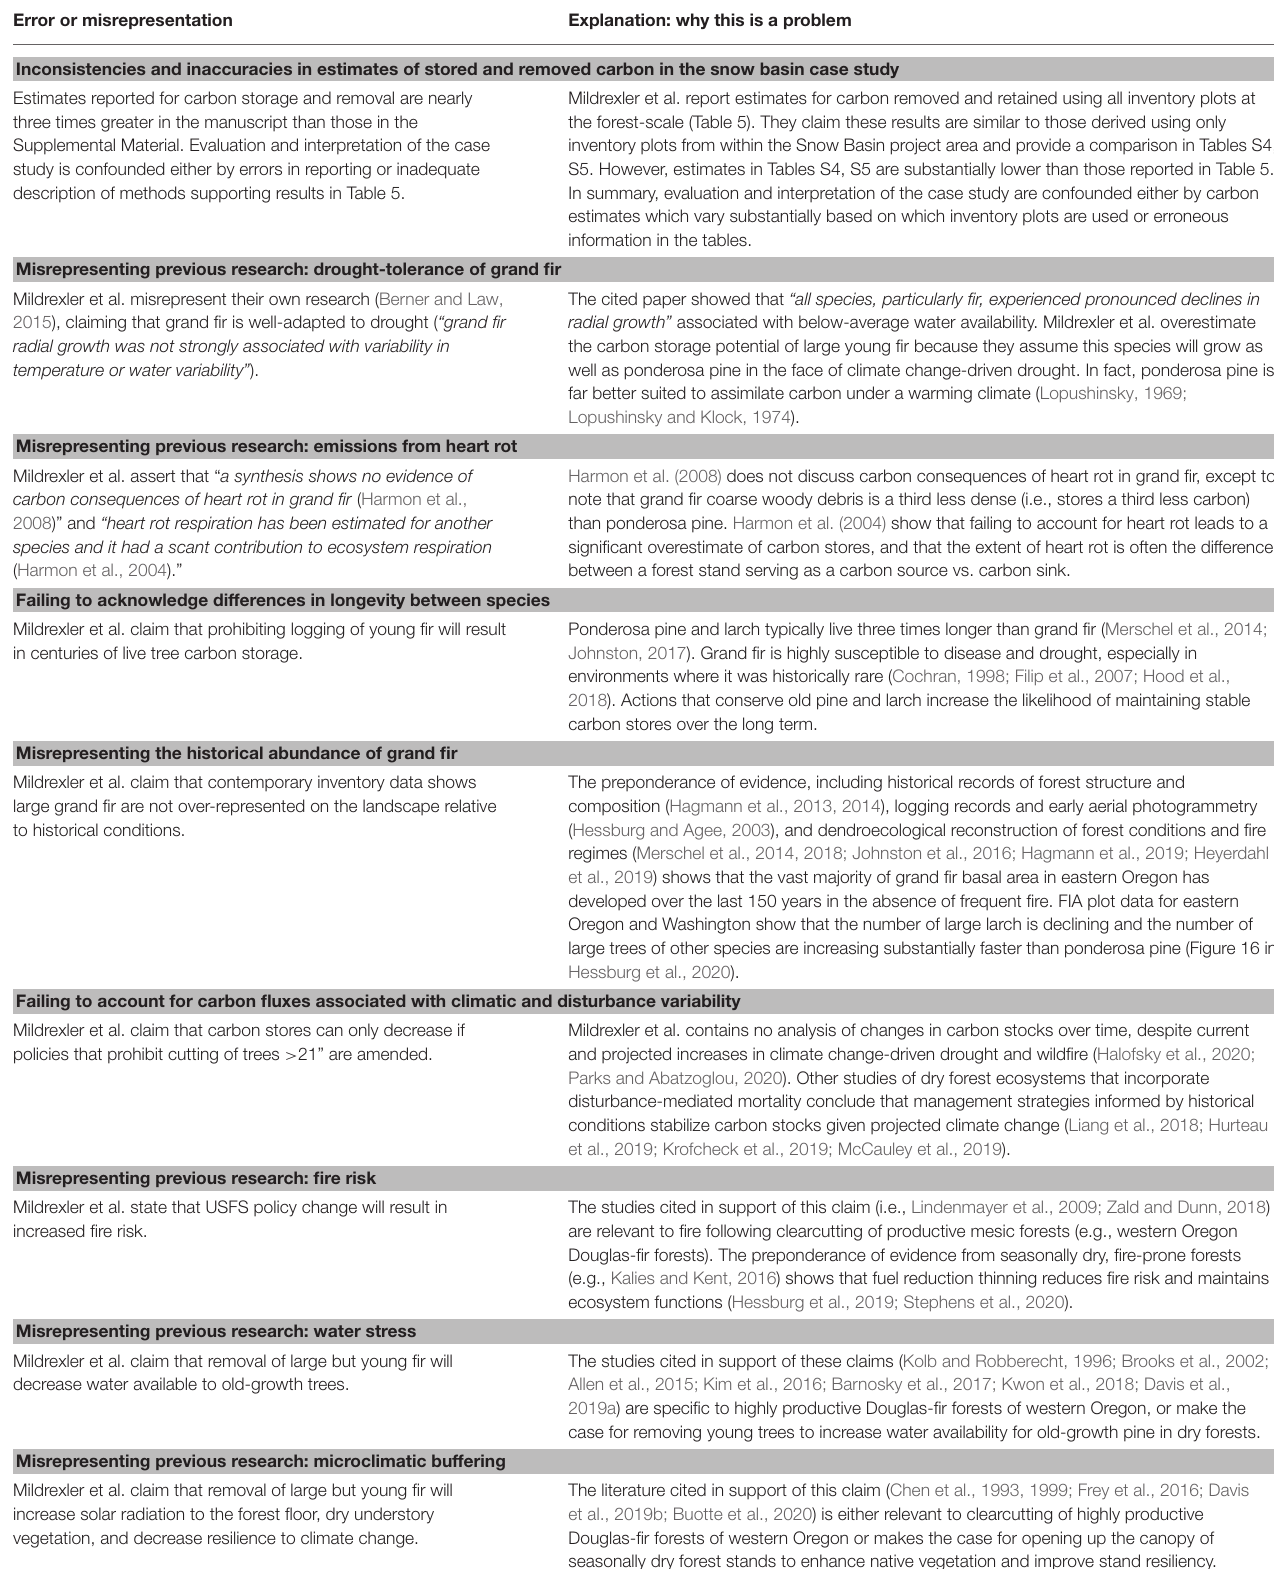
TABLE 1 | Summary of key errors and misrepresentations in Mildrexler et al.